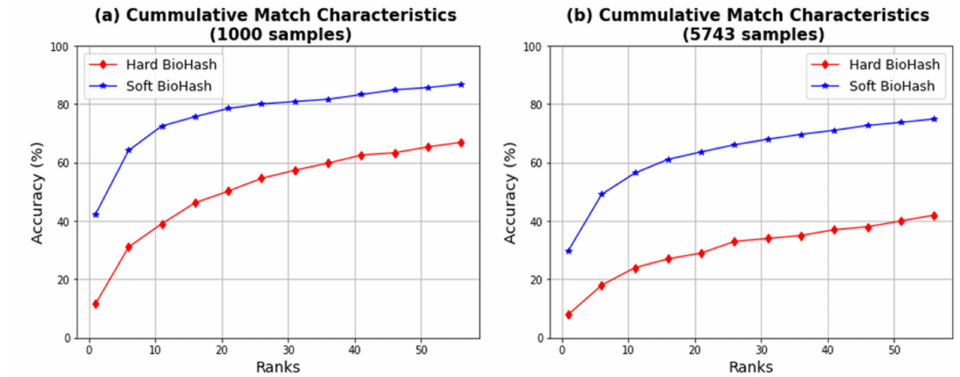
Figure 9. CMC curves of retrieval performance comparing the proposed method and traditional method when examined for different numbers of data samples.